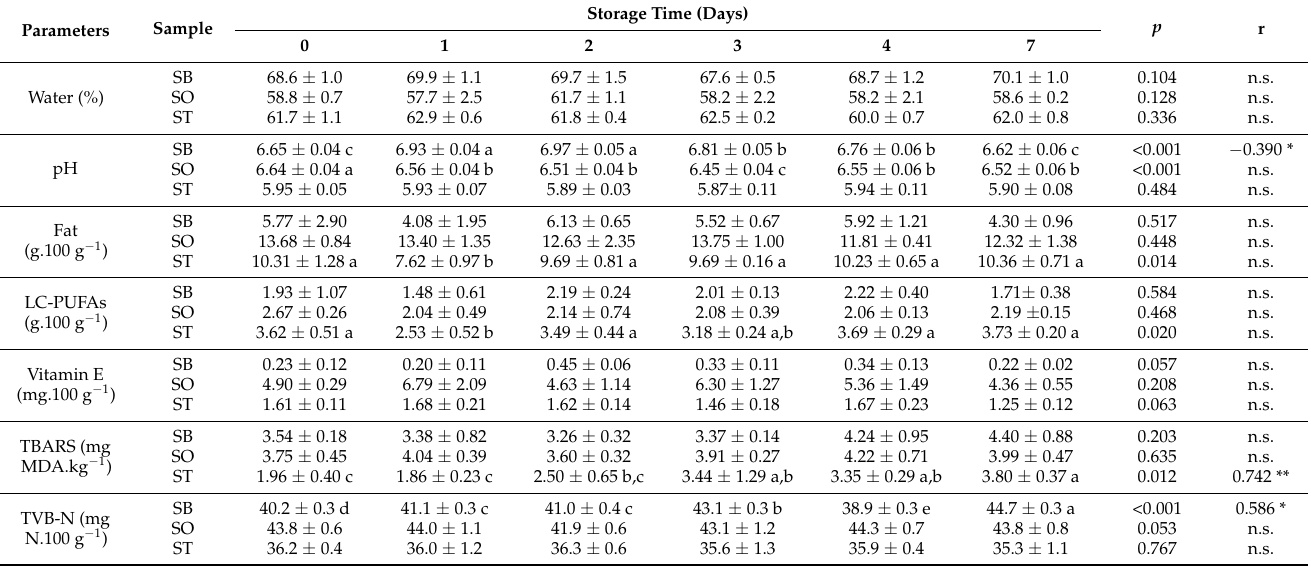
Table 1. Physicochemical characterization of canned sardines during storage at 4 ◦ C (mean ± standard